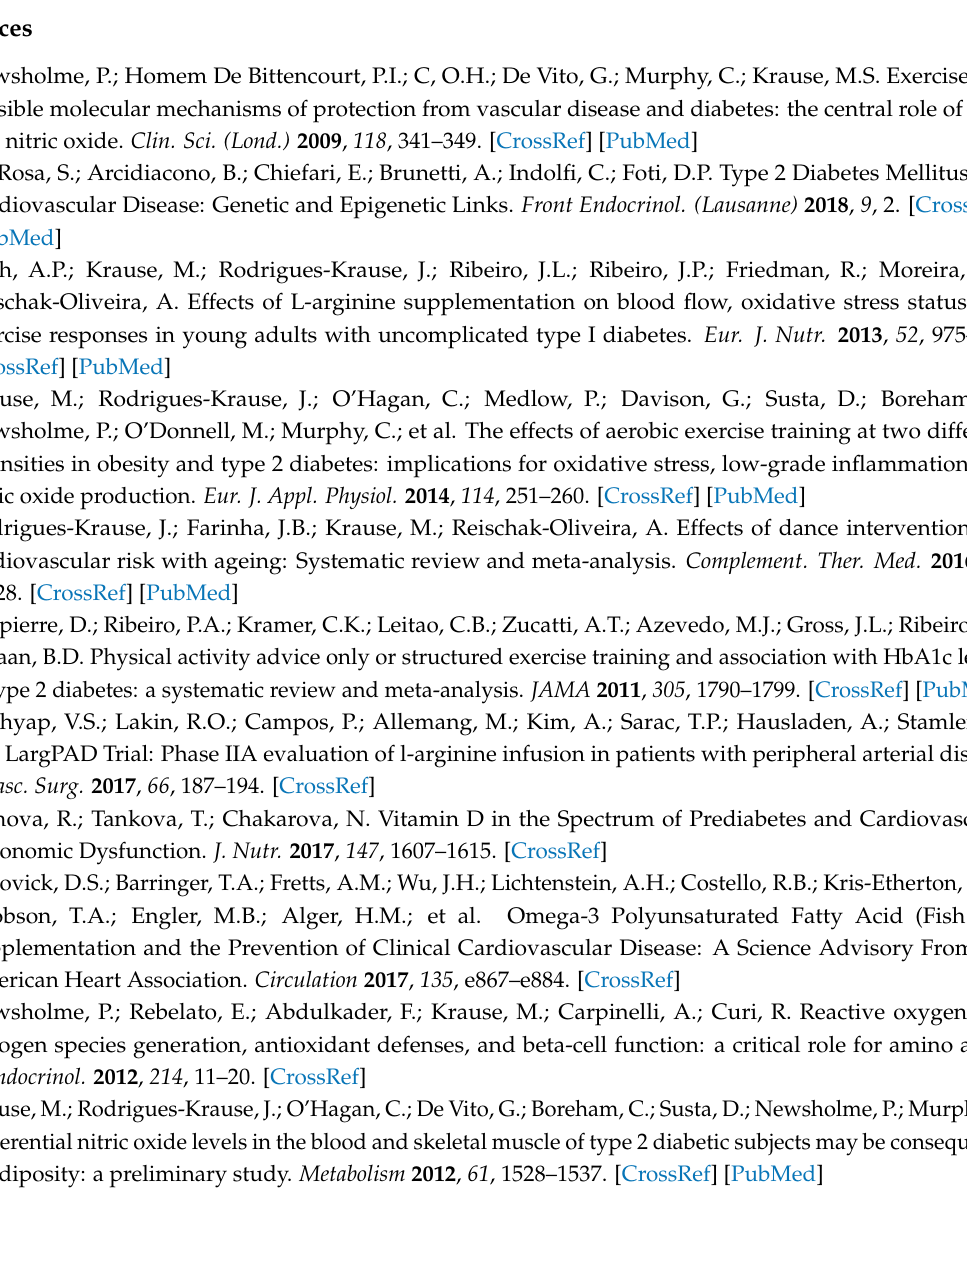
Table S1. Full text articles and reasons of exclusion in the